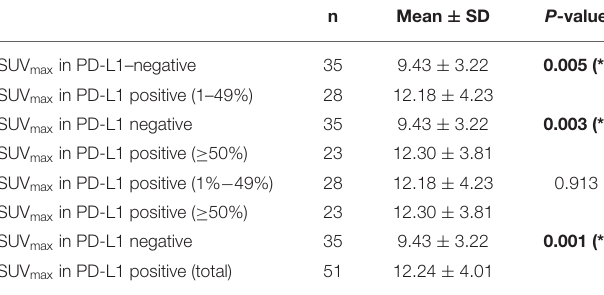
TABLE 2 | The association between SUV max and PD-L1